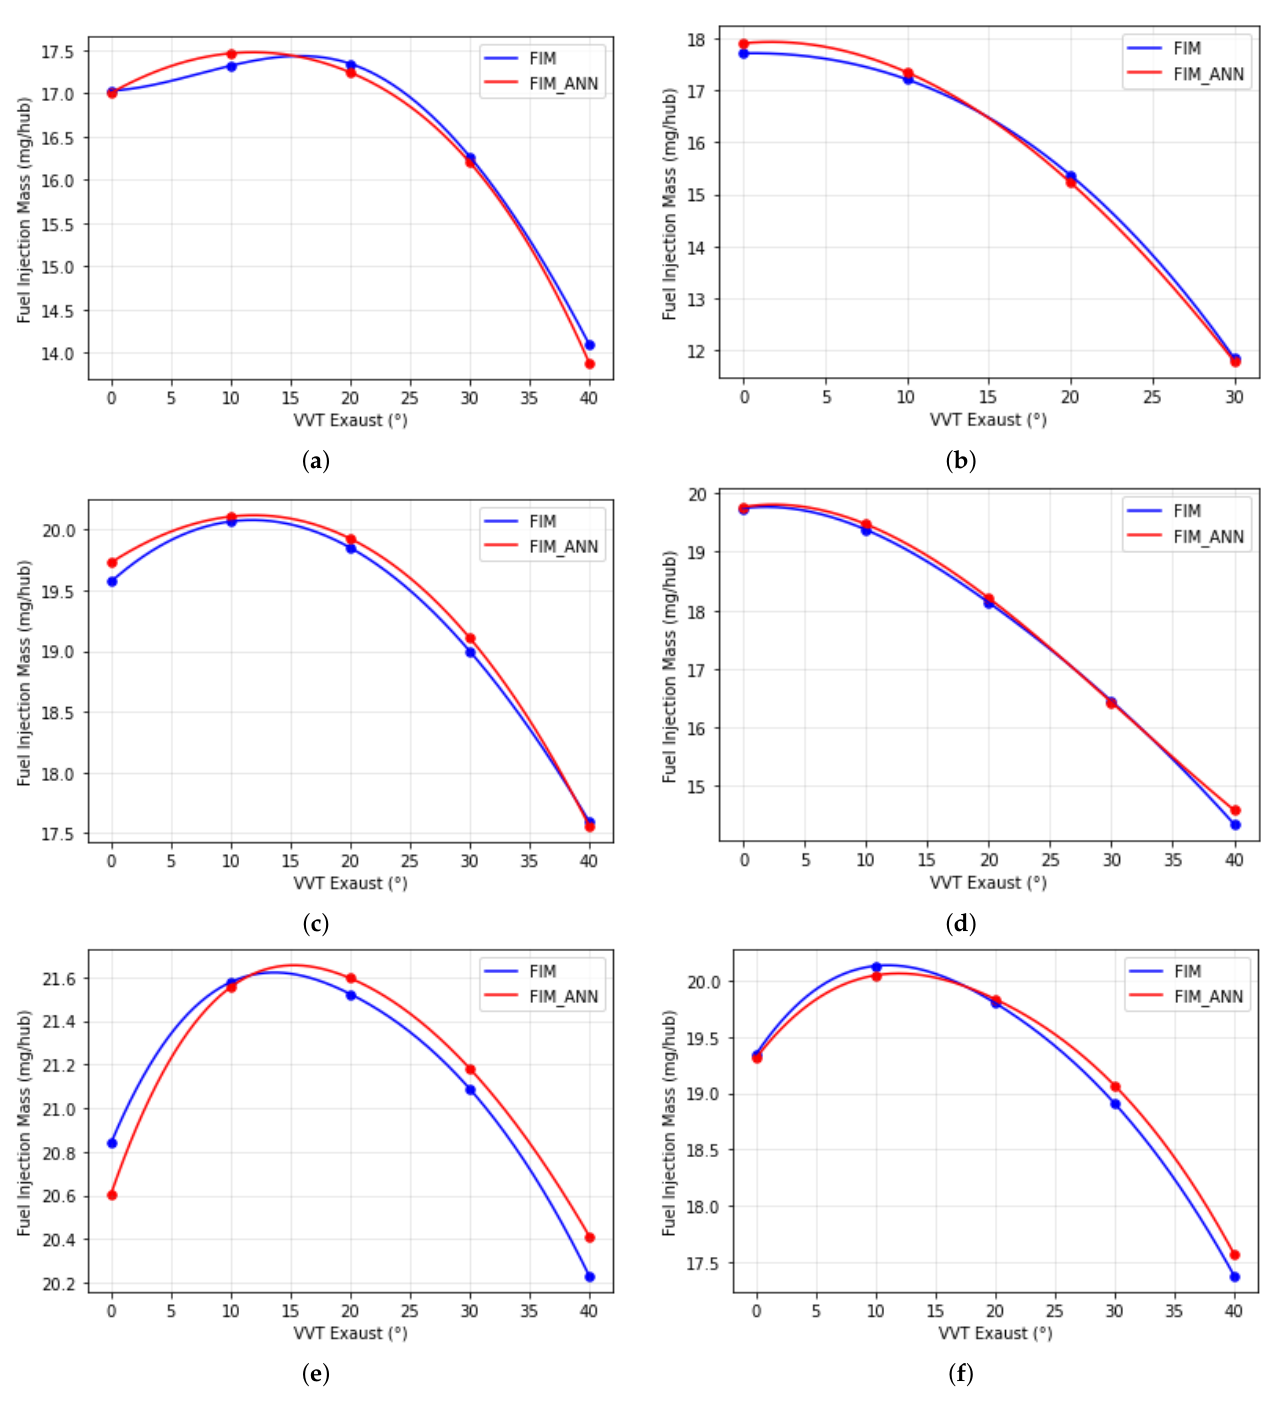
Figure 11. Fuel Injection Mass vs. VVT Exaust in 540 mbar and ( a ) Engine Speed